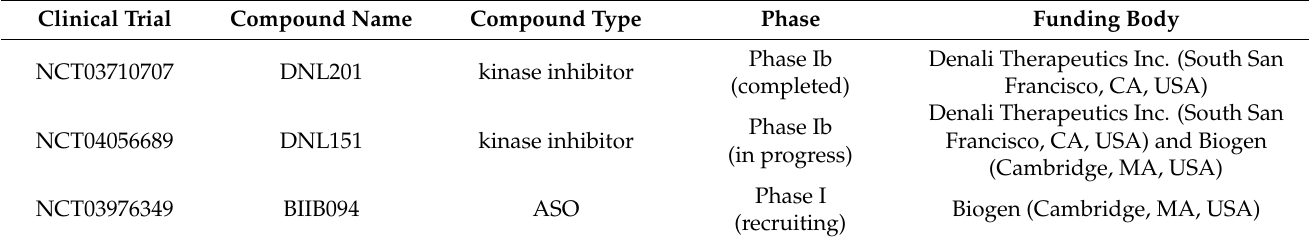
Table 4. LRRK2 therapeutics that are currently in clinical